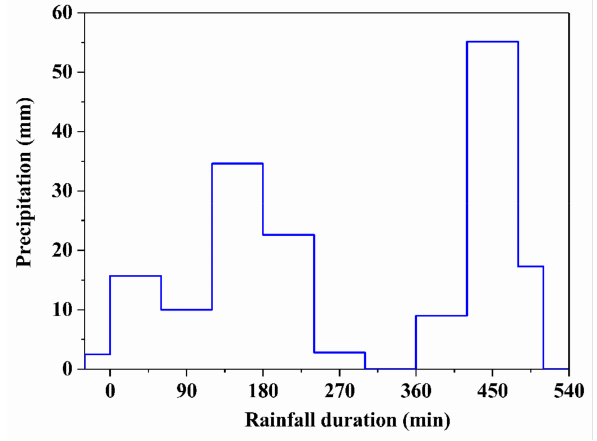
Figure 2. Rainfall distribution process of the “7.26” rainstorm event at the Wangmaogou meteorolog- ical station.